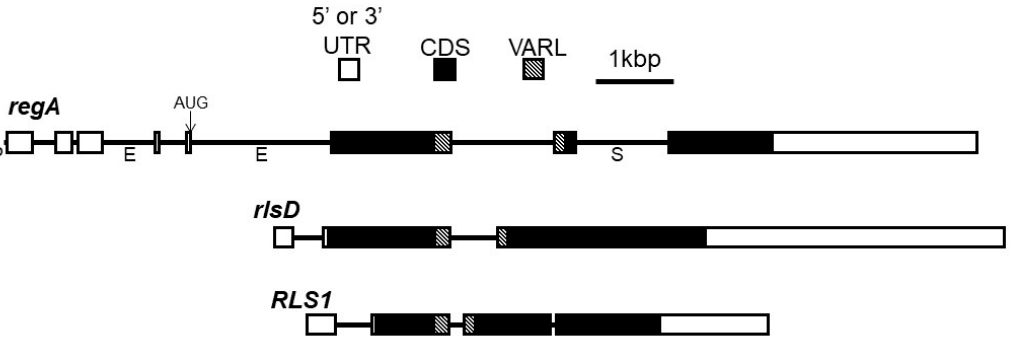
Figure 3. Gene structure diagrams for regA and rlsD in V. carteri f. nagariensis and RLS1 in C. reinhardtii . Exons are shown as boxes with untranslated regions in white and coding regions in black. The portion of the coding region encoding the VARL domain is indicated with striped pattern. Introns are shown as lines between exons, and the 42 bp minimal promoter of regA is shown before first exon and labeled as “P”. regA introns labeled as “E” and “S” denote locations of enhancer and silencer cis -regulatory elements, respectively. Figure based on the study by Kirk [37].